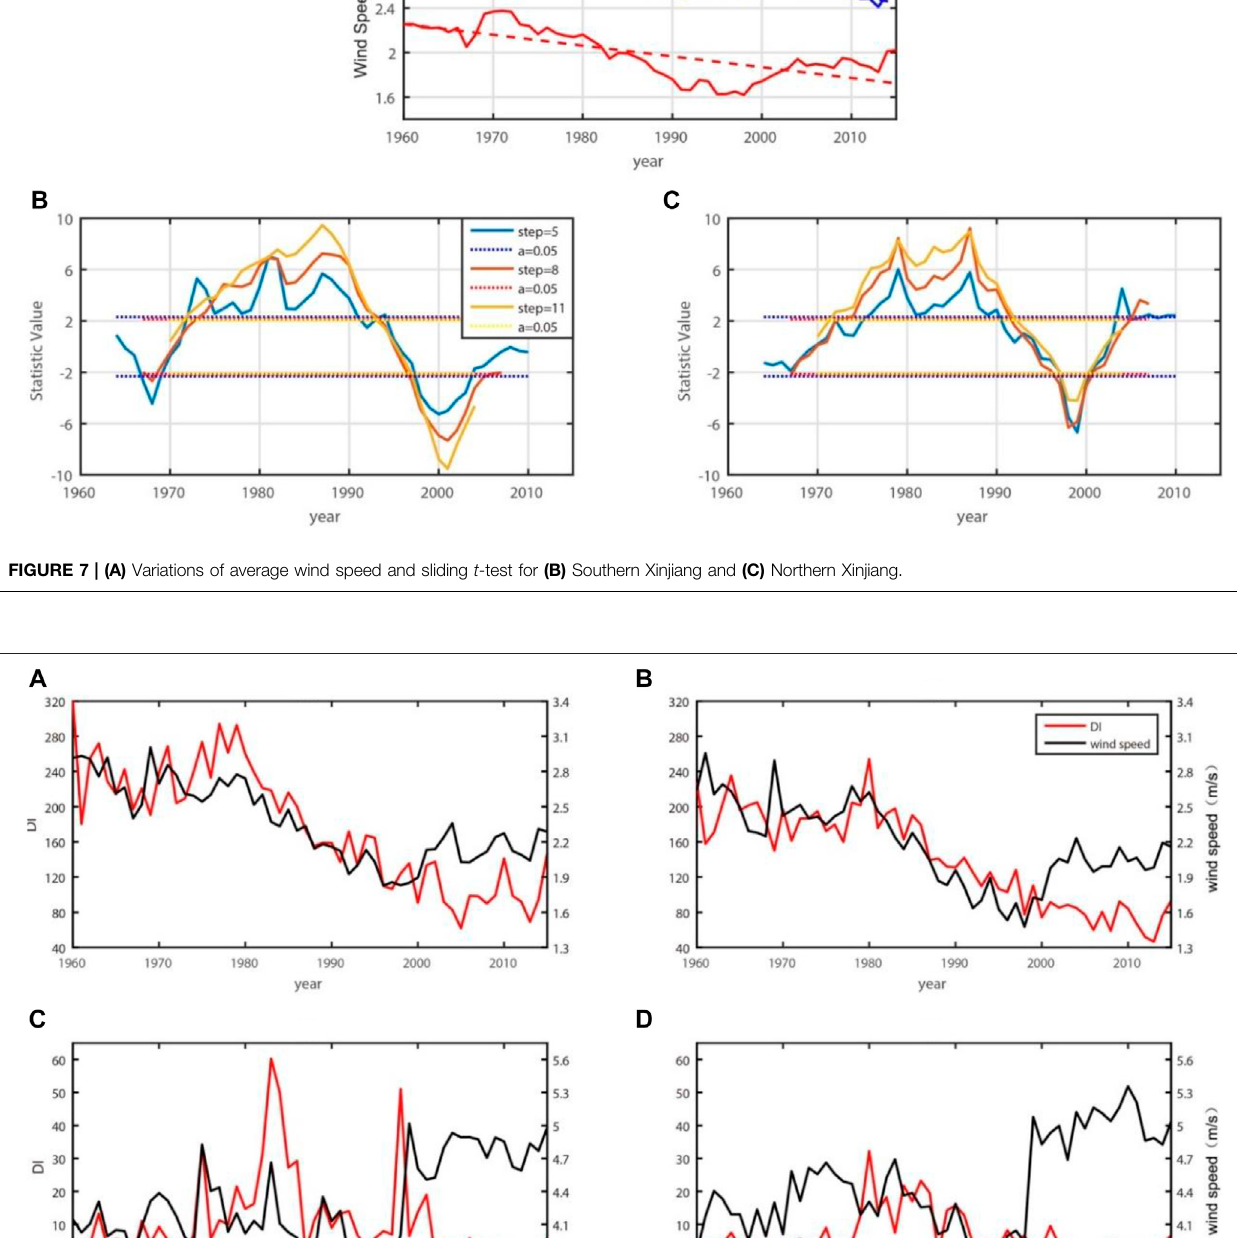
Frontiers in Environmental Science |